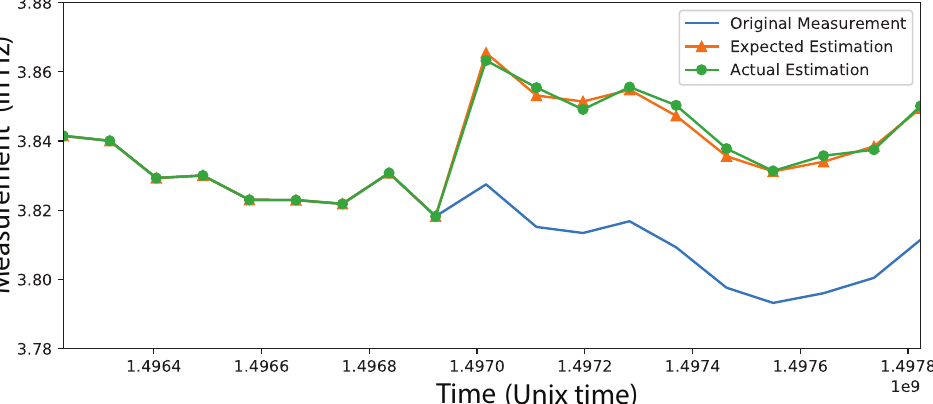
Figure 8. The estimation of first mode using a 24-hour time window for the current quantity and imposing shift of 1%. With orange we plot the exact imposed shift and with green we plot the estimation provided by the SM. We observe very good